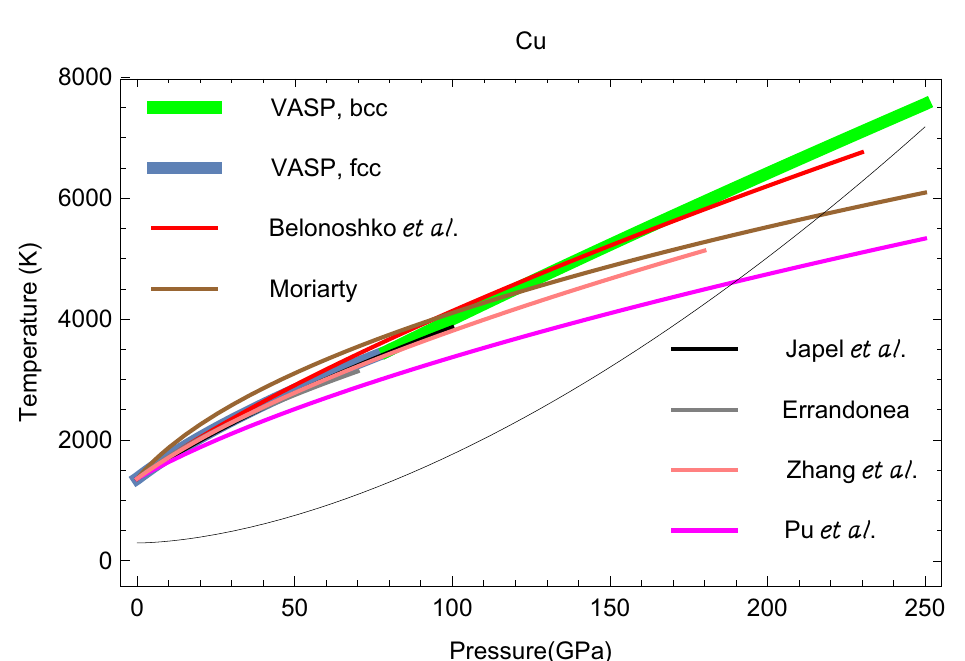
Figure 8. Comparison of the ab initio melting curve of Cu calculated in this work (which combines both lower- P fcc and higher- P bcc segments) to several melting curves of Cu available in the literature: Errandonea [30], Belonoshko [38], Pu et al. [40], Japel et al. [45], Moriarty [46], and Zhang et al. [47]. The Cu principal Hugoniot is also shown as a thin black